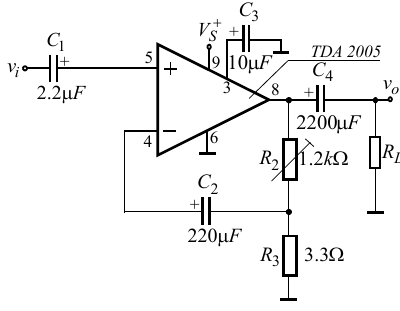
Figure 6. Test circuit [17] for simulation and experimental testing at various voltage gains A V , through the feedback resistor R 2